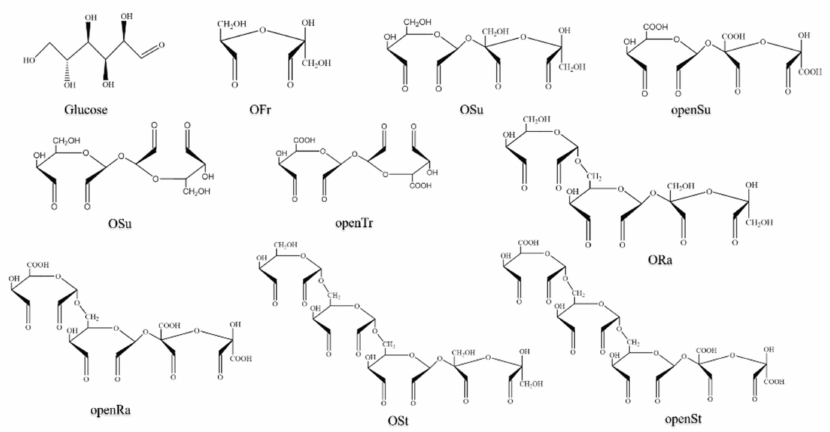
Figure 3. Structure of glycosyl polyaldehydes and glycosyl polyuronic acid finishing agents.